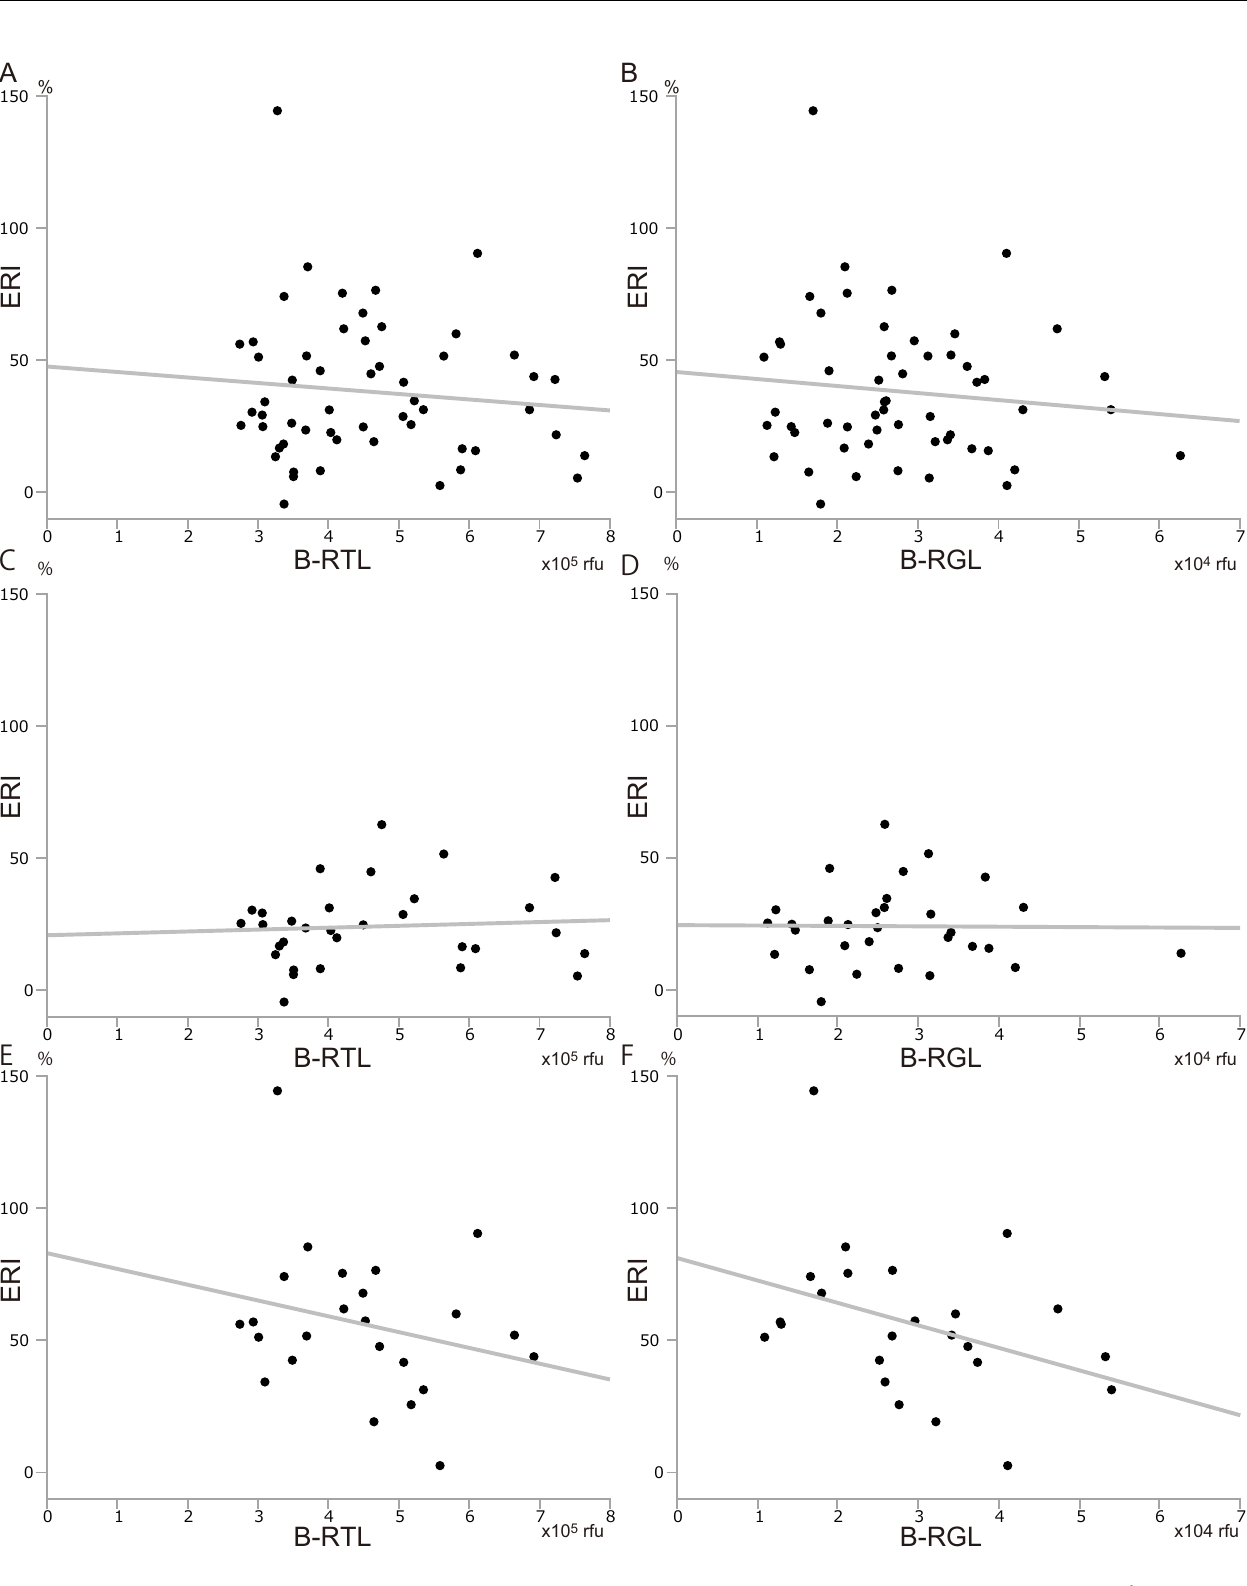
PLOS ONE | https://doi.org/10.1371/journal.pone.0213462 March 7,